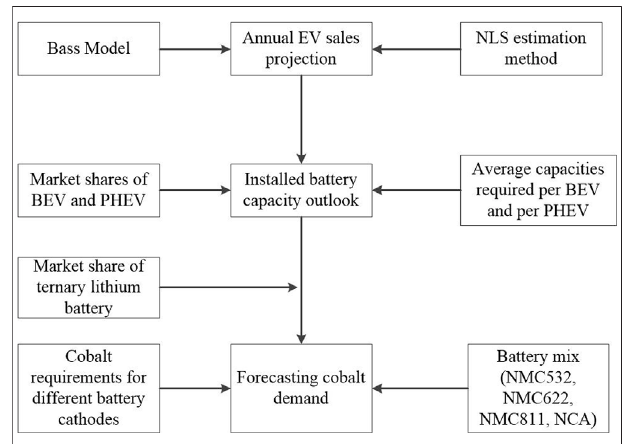
FIGURE 1 | Framework for forecasting the cobalt demand in China (2021 –